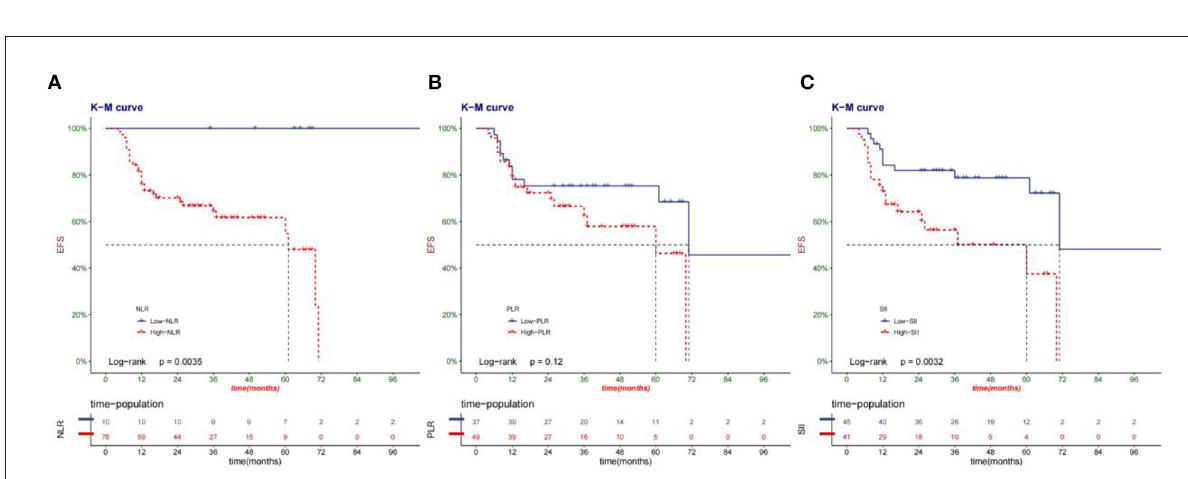
FIGURE4 Kaplan-Meier curve of the EFS of patients according to NLR (A) , PLR (B) , and SII (C) group.